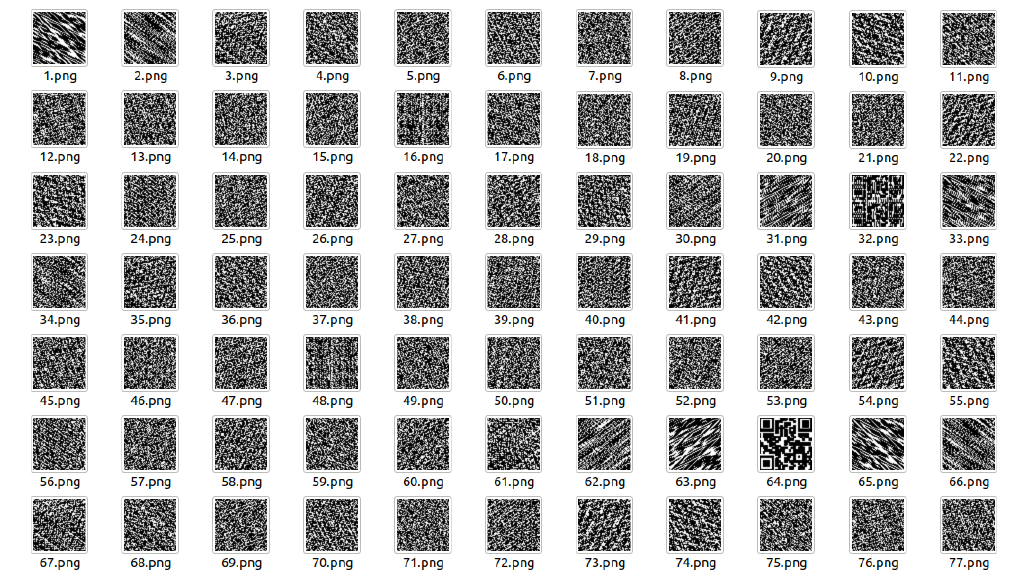
Figure 3. Scrambled watermark and recovered